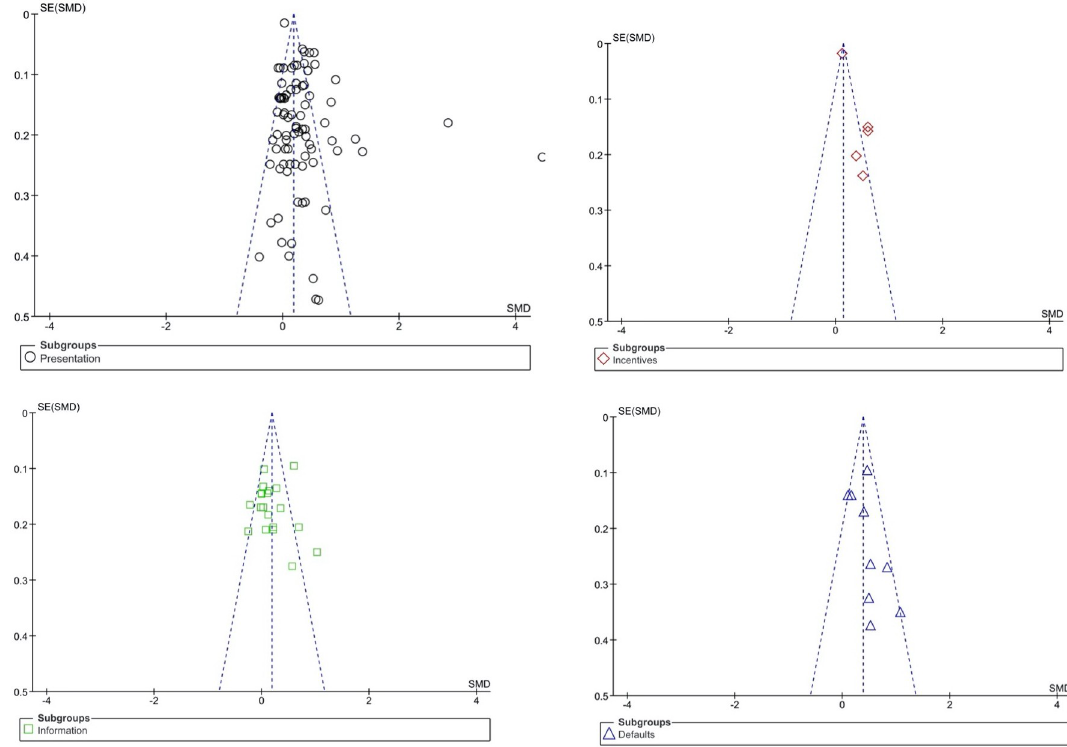
Fig 5. a. Funnel plot for presentation nudging. b. Funnel plot for incentive nudging. c. Funnel plot for information nudging. d. Funnel plot for information